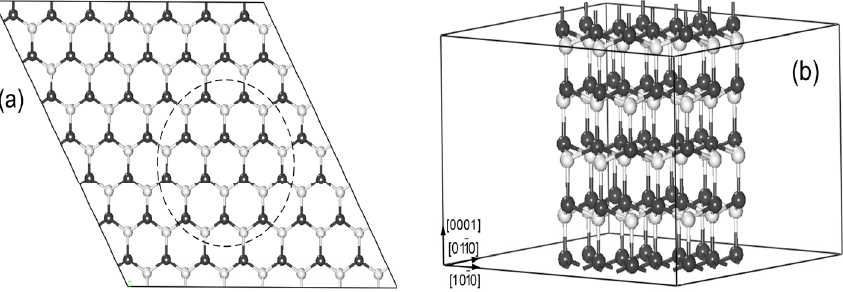
Figure 1. ( a ) The top view of the 7 × 7 × 2 ZnO supercell structure; ( b ) Zn 48 O 48 nanowires (NWs) supercell along the [0001] direction (The white and black spheres represent O and Zn atoms).